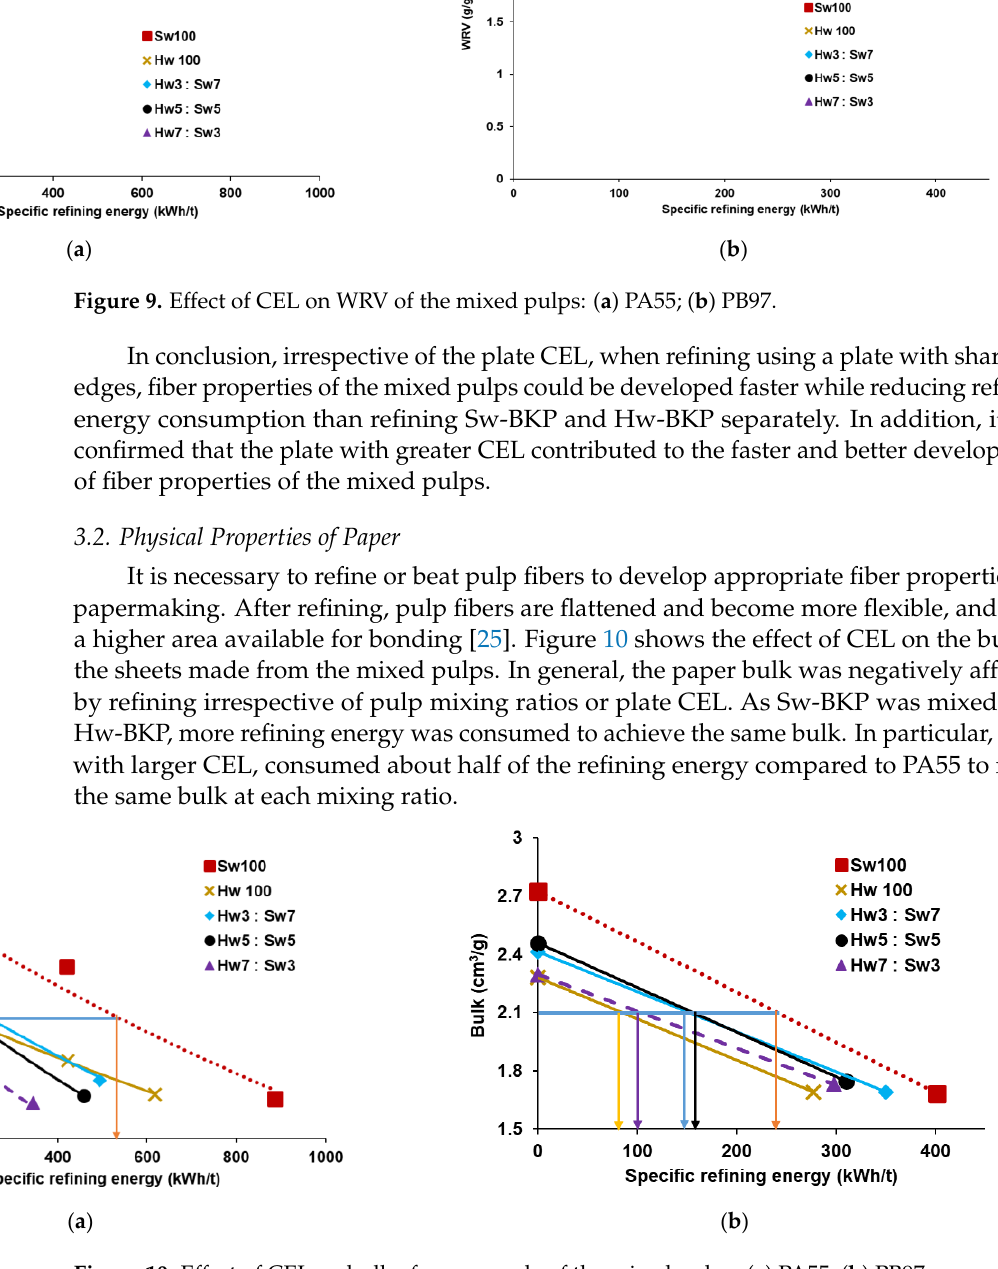
( b ) Figure 11. Effect of CEL on tensile strength of paper made of mixed pulps: ( a ) PA55; ( b ) PB97. In the case of PA55, the refining energy for the mixed pulps of Hw-BKP and Sw-BKP required up to the same tensile strength was less than the energy for the independent